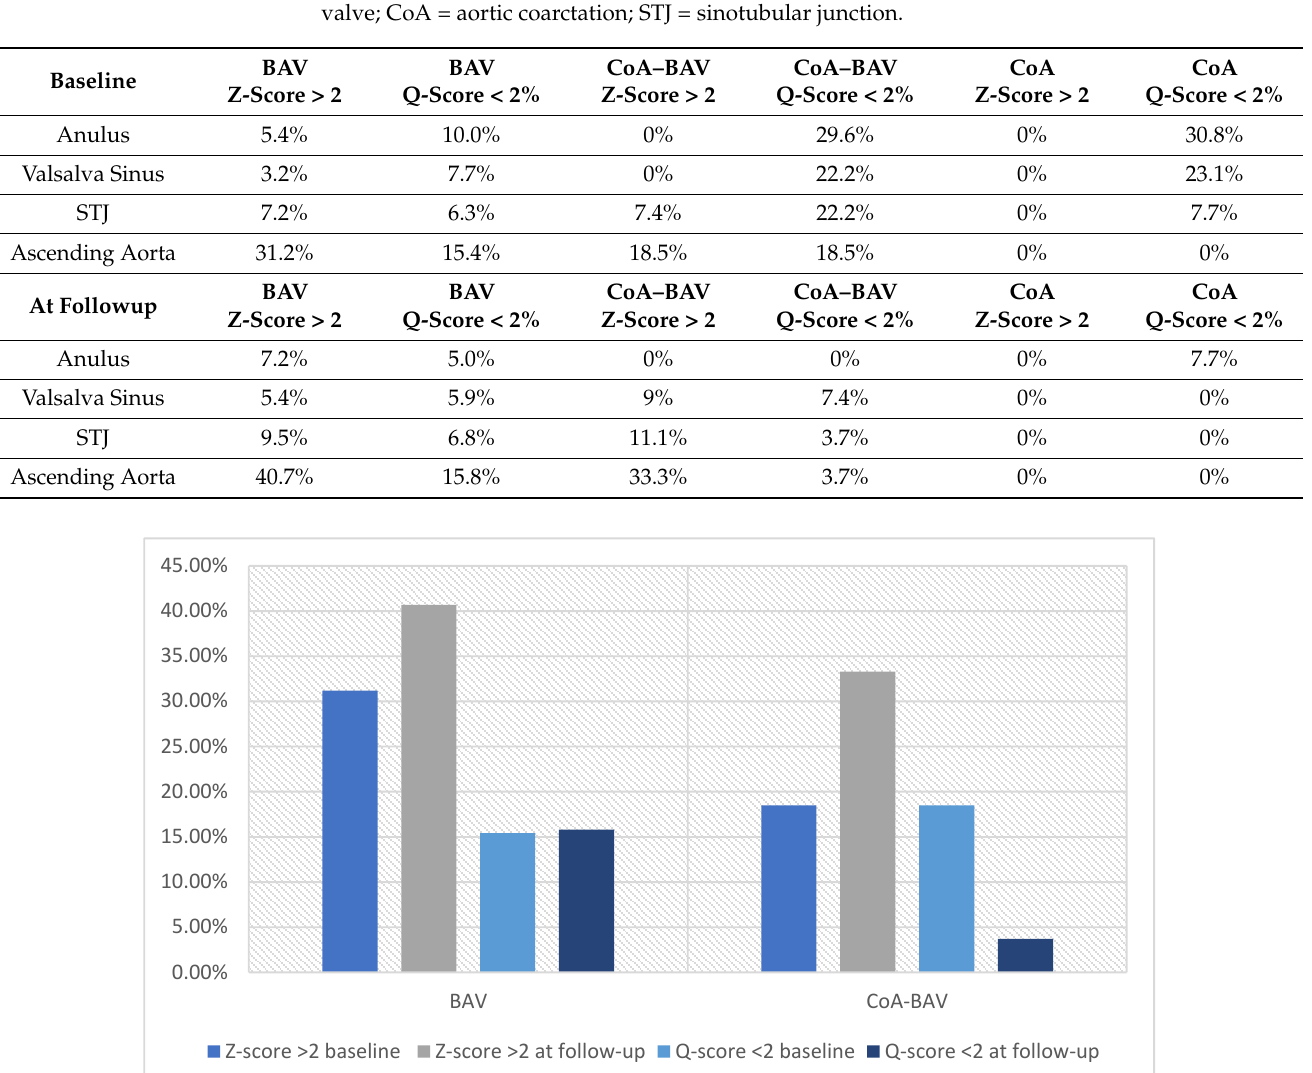
Table 3. Prevalence of aortic dilation by comparing Z-scores and Q-scores. BAV = bicuspid aortic valve; CoA = aortic coarctation; STJ = sinotubular junction.